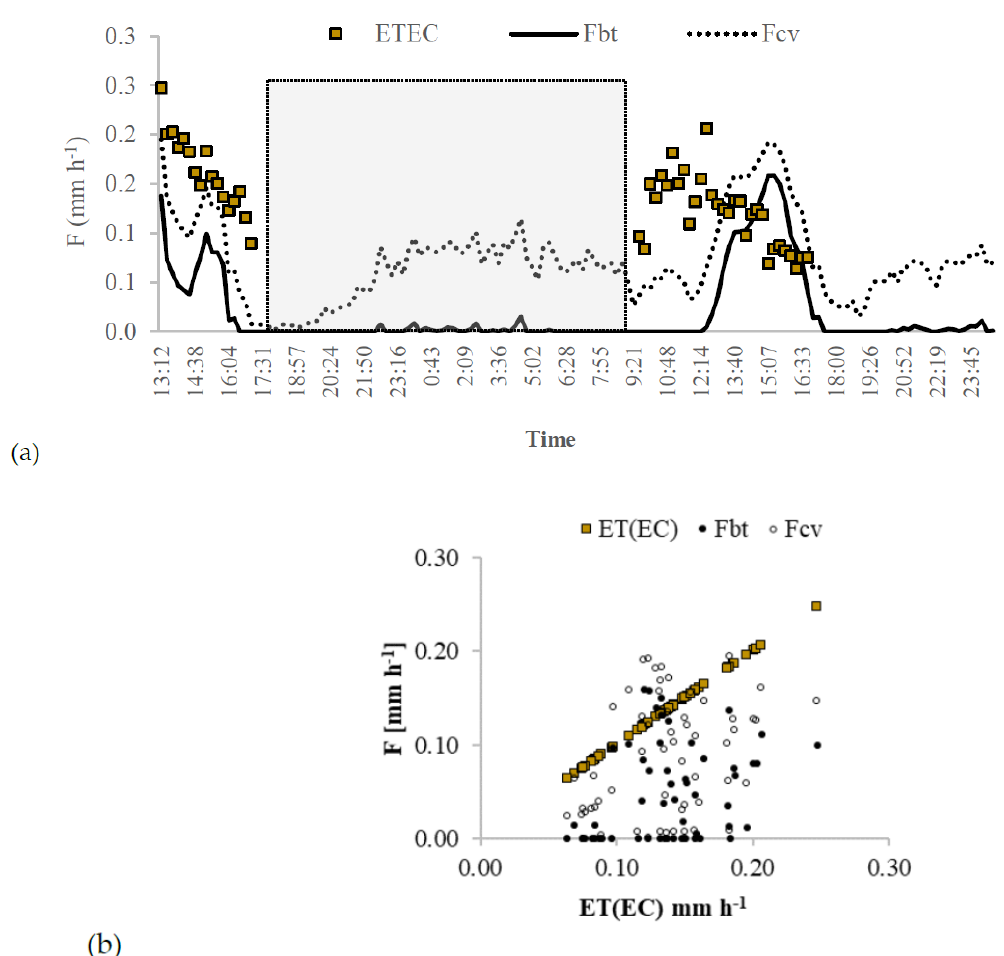
Figure 11. Raw data obtained between days 14–16 October 2016 with an eddy covariance instrument (EC) and a Biot-Granier sensor set (SP32L) (Experiment III): ( a ) circadian curve of the evapotranspiration measurements (ET(EC), mm h − 1 ) and the adjusted sap flow rate measured in function of conventional Granier sap flow index (k cv ) and Biot number Granier sap flow index (k bt ) approaches; ( b ) dispersion of the transpiration data (F bt and F cv ) around the fitted line of the ET(EC).